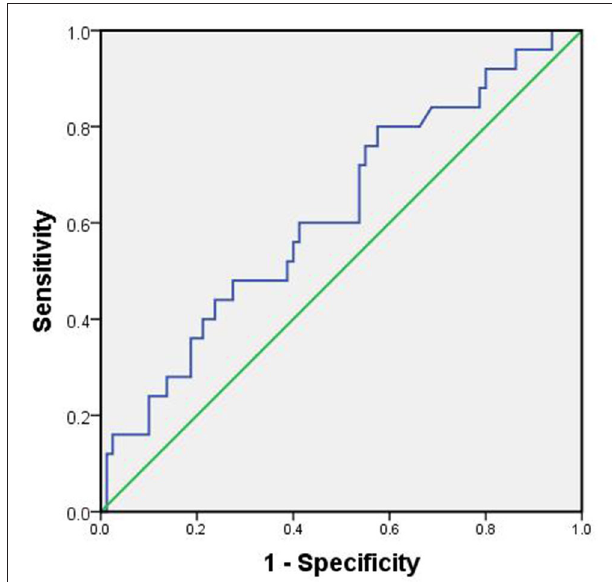
FIGURE 2 | ROC curve of WBC.